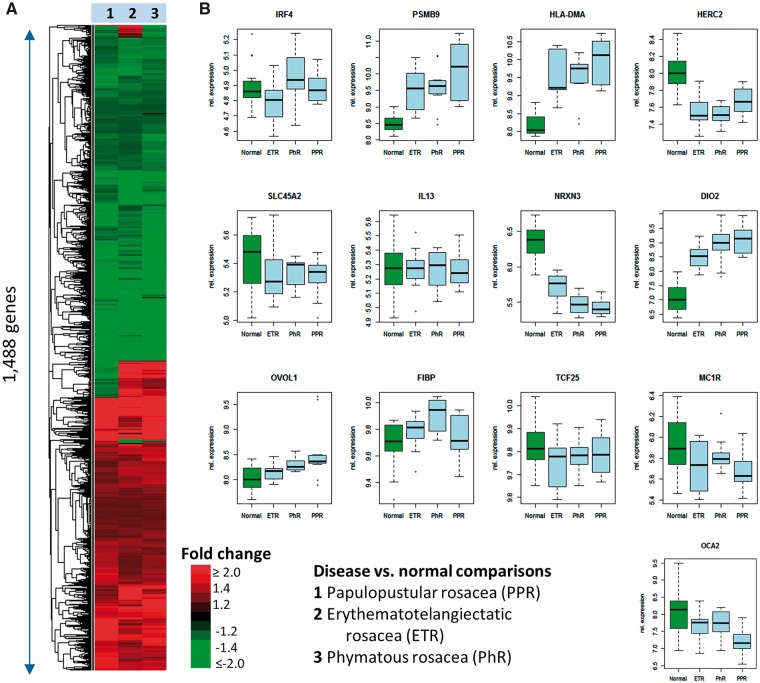
Reanalysis of previously published mRNA expression in three rosacea subtypes (7). Samples from patients with PPR, ETR and PhR were compared with samples from healthy volunteers. The heatmap and hierarchical clustering of fold changes comparing rosacea samples against healthy signatures for each subtype shows that the three subtypes were highly similar with erythematotelangiectatic and PhR appearing more closely related than PPR (A). Differential expression analysis of selected genes showed that five genes in the eight gene regions that were associated with rosacea were differentially regulated in rosacea gene expression data (PSMB9_HLA-DMA, HERC2 and DIO2_NRX3) (B).